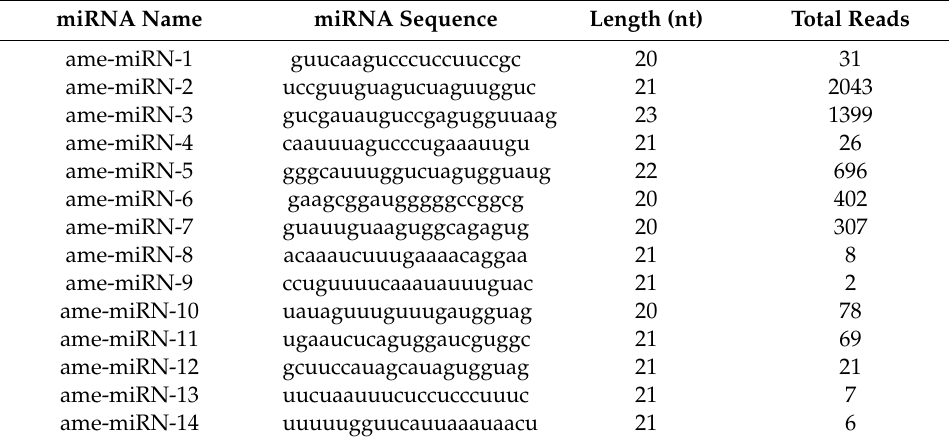
Table 3. Non-conserved miRNAs predicted from A.